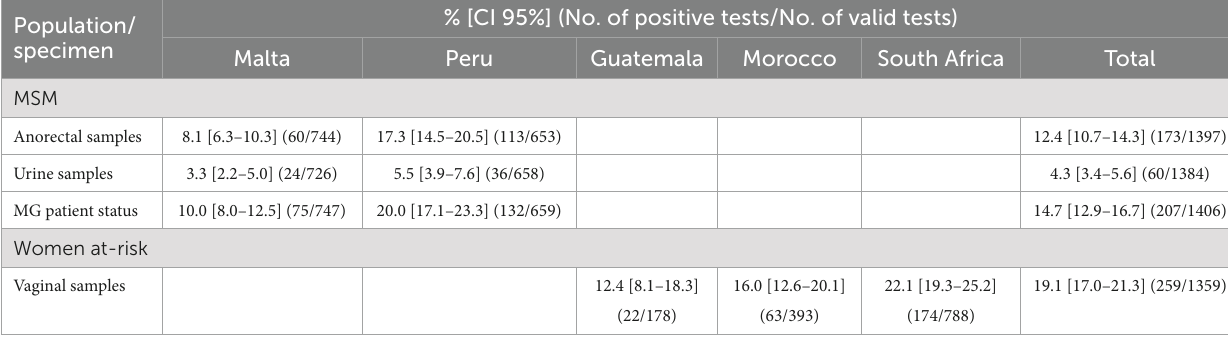
TABLE 1 Prevalence of Mycoplasma genitalium in high-risk populations in five countries in four WHO Regions. Population/